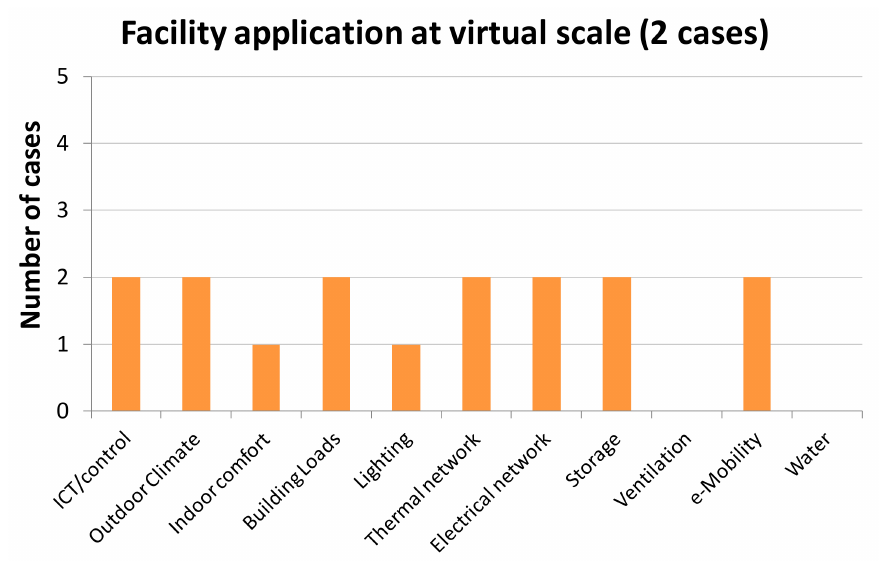
Figure 17. Histogram of occurrence obtained for the facility applications at the virtual scale.